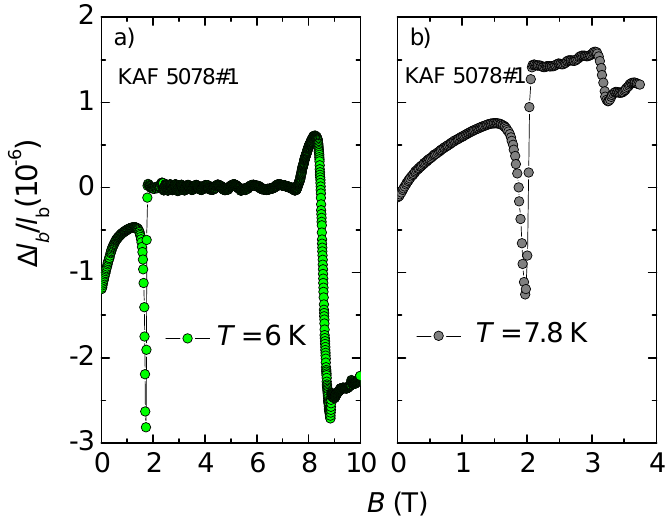
Figure 5. Relative length changes along the b -axis, ∆ l b / l b , for κ -(BEDT-TTF) 2 Cu 2 (CN) 3 (KAF 5078#1) as a function of applied magnetic field, B (cid:107) b , at a temperature ( a ) T = 6 K and ( b ) T = 7.8 K. The oscillations in the data, being periodic in B − 1 , are due to quantum oscillations of gallium ( Ga ) used for affixing the sample in the desired